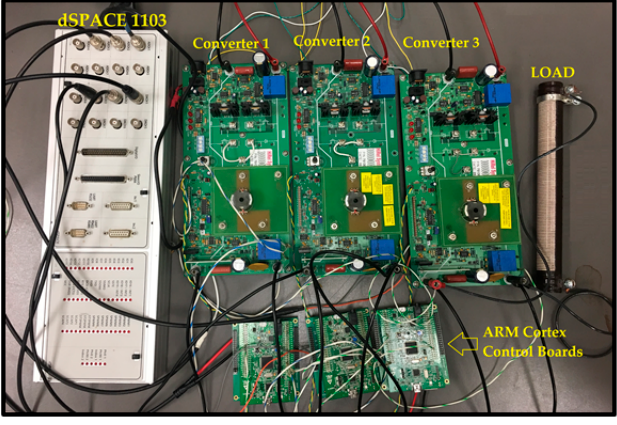
Figure 15. Hardware setup for the GPS carrier synchronization.